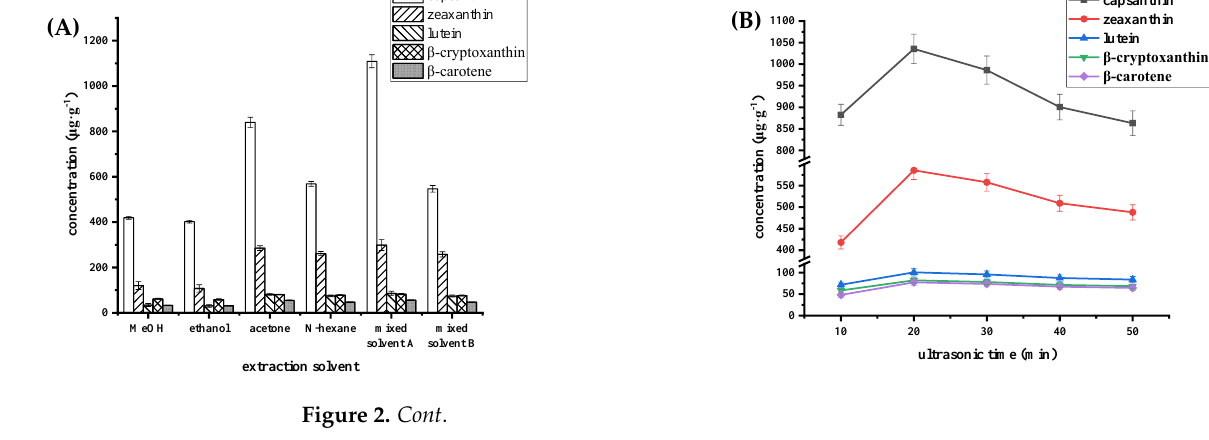
Figure 2. Concentrations of capsanthin, zeaxanthin, lutein, β - cryptoxanthin and β -carotene under different extraction conditions ( A ) extraction solvent, ( B ) ultrasonic time, ( C ) ultrasonic tempera- ture, ( D ) KOH concentration, ( E ) saponification temperature, ( F ) saponification time. 2.3. Methodological Evaluation Table S2 displays the repeatability test results during four sessions of three groups of mixed standard samples at various concentrations throughout a 14-day period. The RSD% of retention times of capsanthin, zeaxanthin, lutein, β - cryptoxanthin and β -carotene were 0.04~0.22%, 0.05~0.15%, 0.05~0.29%, 0.07~0.17% and 0.03~0.08%, respectively, which were lower than 0.3%. The RSD% of peaks areas of capsanthin, zeaxanthin, lutein, β -cryptoxan- thin and β -carotene were 0.16~1.46%, 0.10~0.75%, 0.31~1.39%, 0.30~0.89% and 0.14~1.01%,